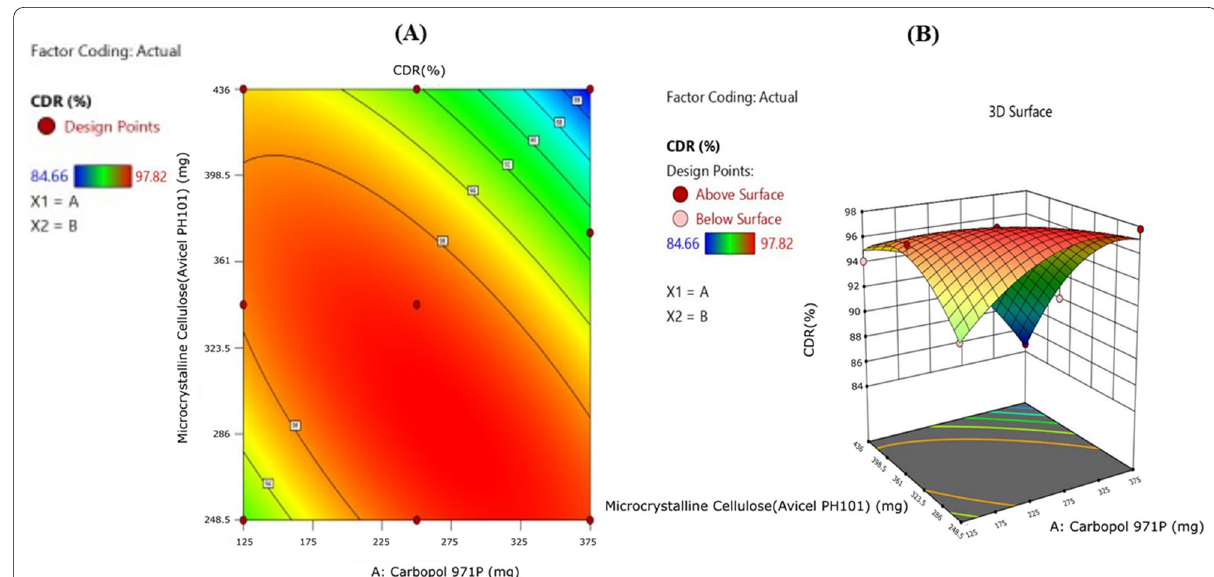
Fig. 2 (A) Contour plot and B Response surface plot for dependent variables of MFH-SR pellets with %CDR as a response